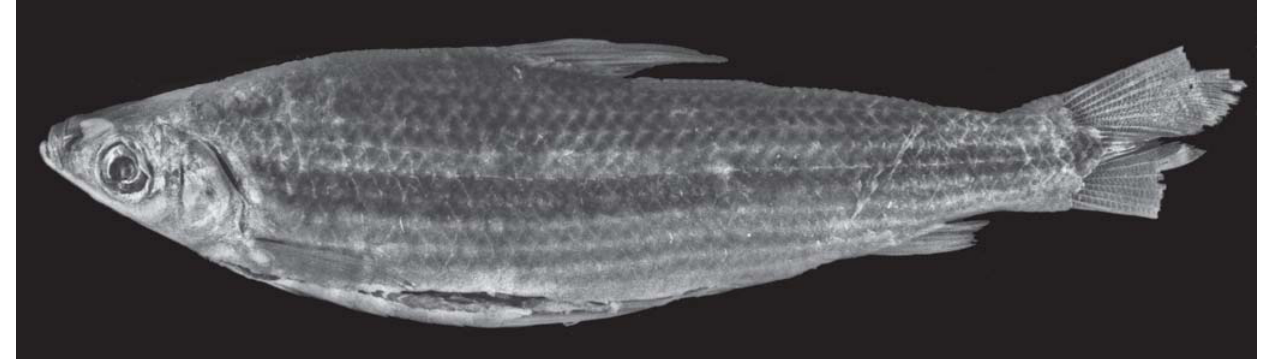
Fig. 19. Laemolyta proxima , MCZ 19331, lectotype, 165.3 mm SL; Brazil, Amazonas, rio Amazonas, Vila Bela,